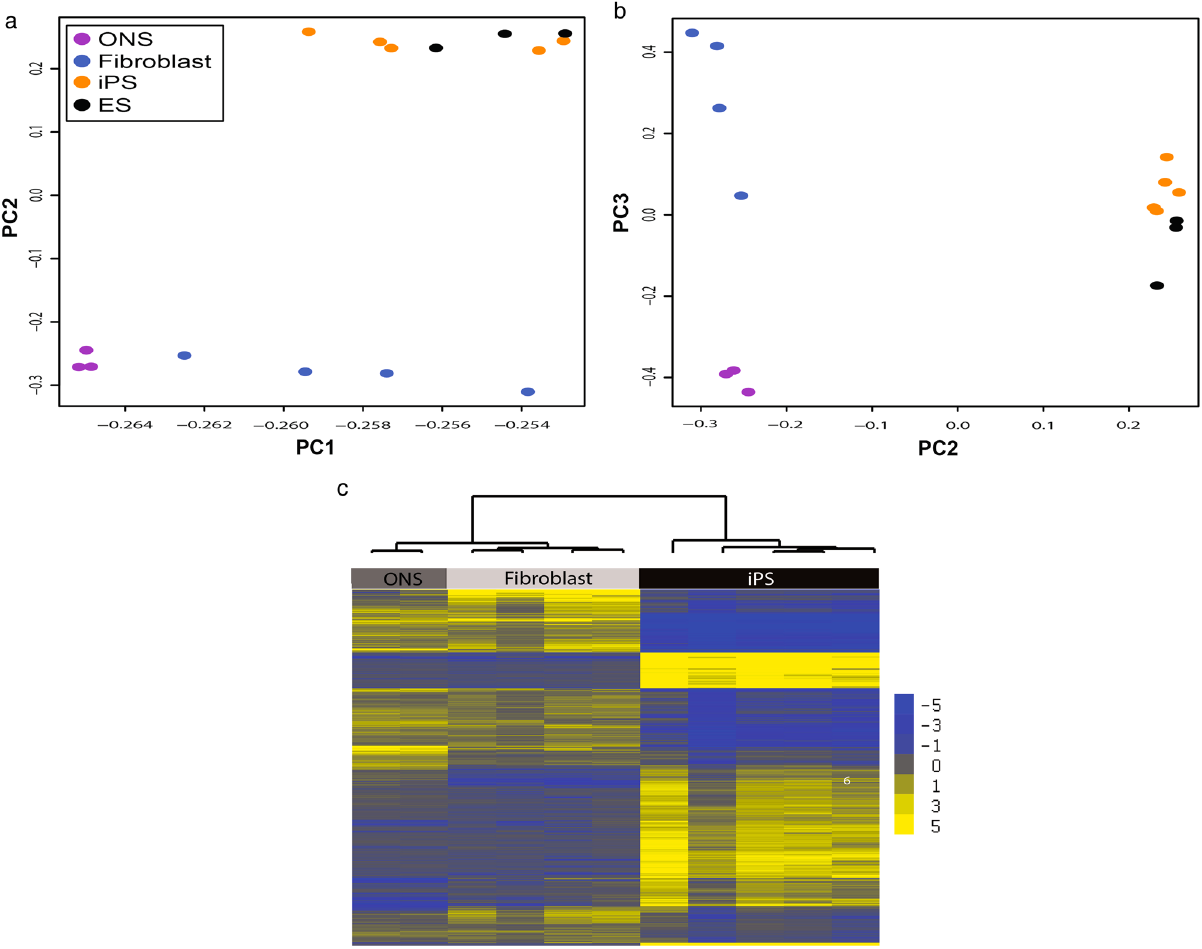
Fig. 2 Cell types have distinct gene expression pro fi les. a , b Unbiased PCA on all detected probes on array demonstrates that cell types are distinguished by the genes they express. a Principal components 1 ( x-axis ) and 2 ( y-axis ) separate the pluripotent cells (iPS and ES cells) from the adult tissue-derived cells (ONS and fi broblasts) and also separate the ONS and fi broblasts. b Principal components 2 ( x-axis ) and 3 ( y-axis ) separate the three cell types from each other. c The individual cell lines separate into cell types after cluster analysis on the probes that were statistically different between the cell types ( p < 0.05, FDR correction). Genes are illustrated as horizontal yellow and blue lines scaled from the average, which is gray . Higher expression than average is yellow . Lower than average is blue . Scale is on right. Statistical clustering similarity is shown by the tree diagram. iPS cells are distinctly different from the adult-derived cells (top branch). ONS and fi broblasts are also distinguished from each other (second branch on the